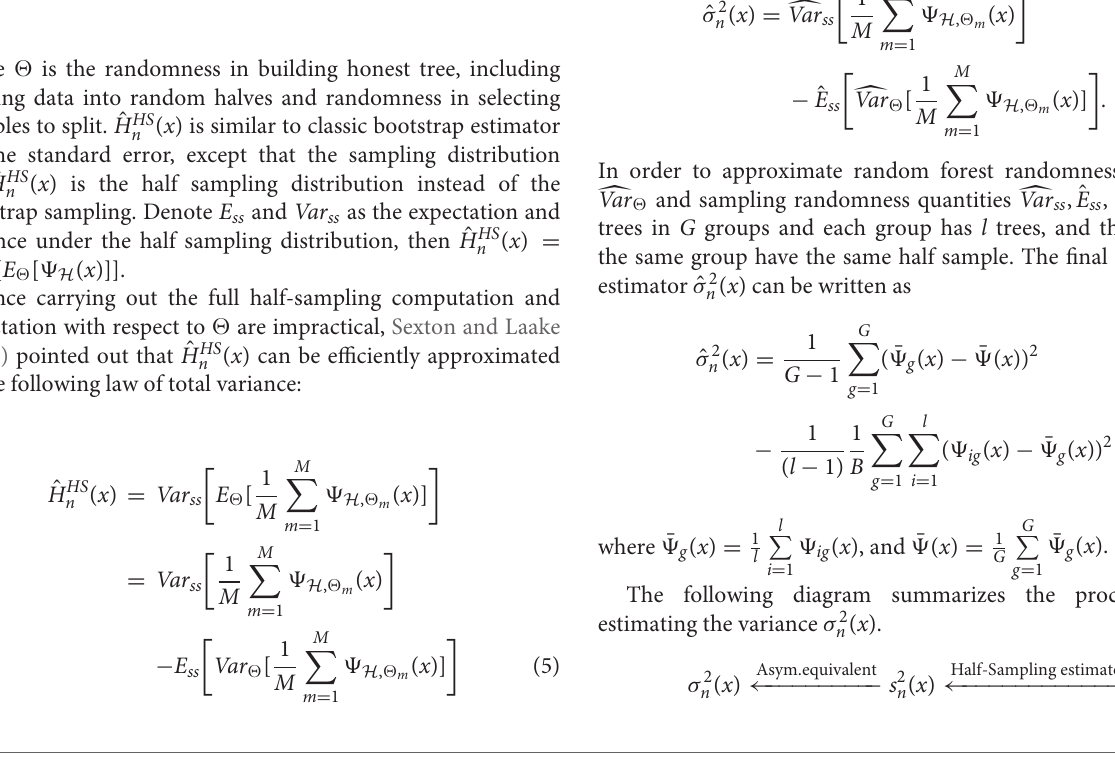
TABLE 2 | Comparison of mean-absolute-error (MAE) and rooted-mean-squared-error (RMSE) for Model 2 with different link functions. p SRF Naive.Cox